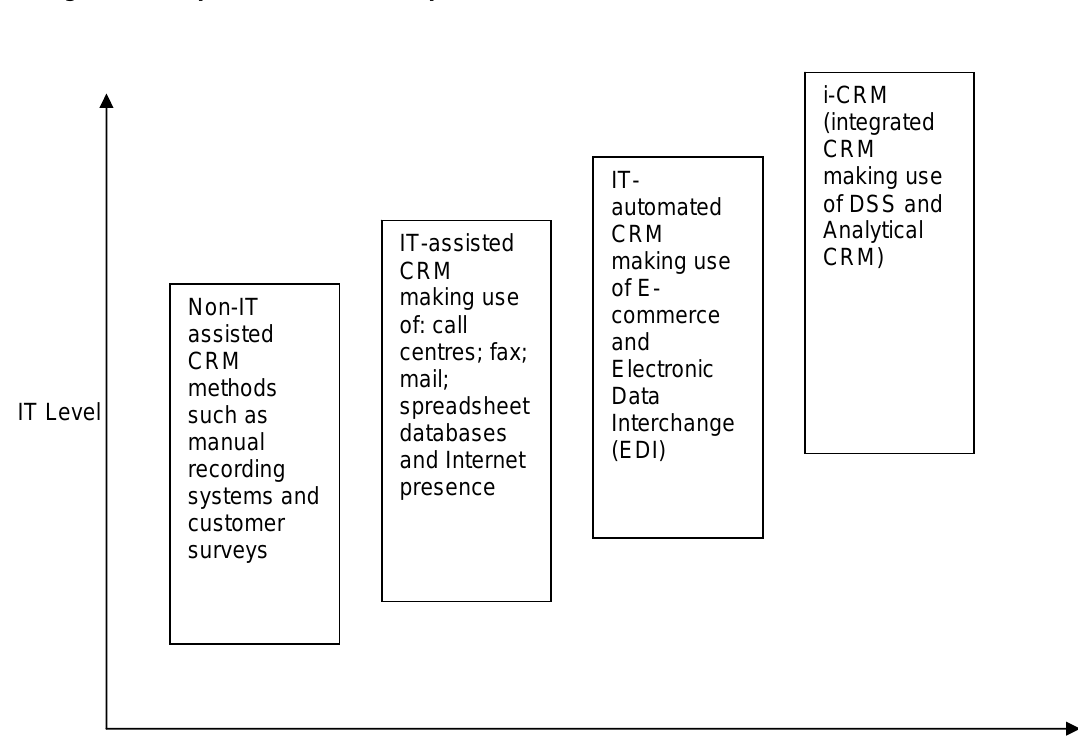
Figure 2: The phases in the development of